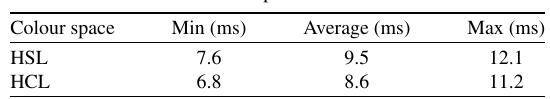
The vision processing time of one frame in the HCL and HSL colour